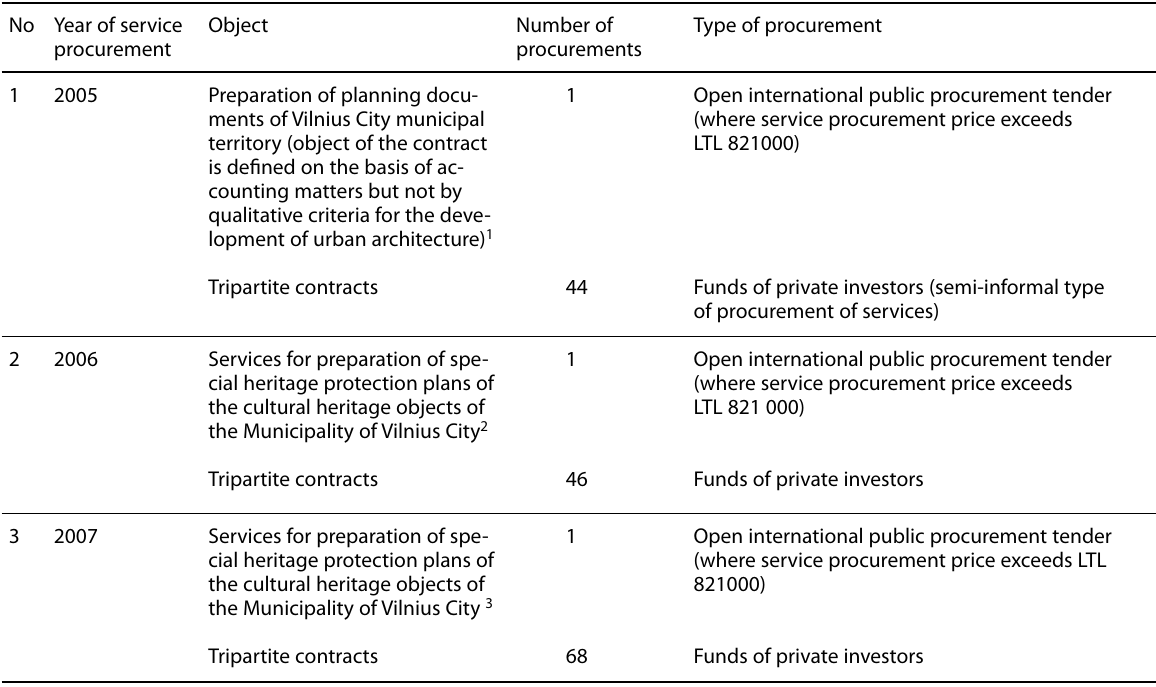
Table 2. Analysis for dissemination of procurement types at Vilnius City